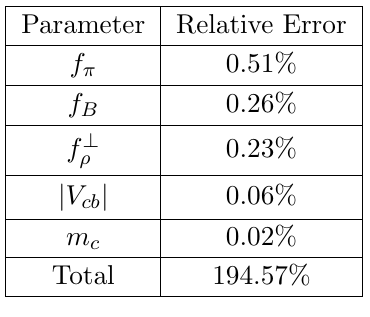
Table 5 . Error budget for the observable S (cid:25)(cid:26) (Part II).